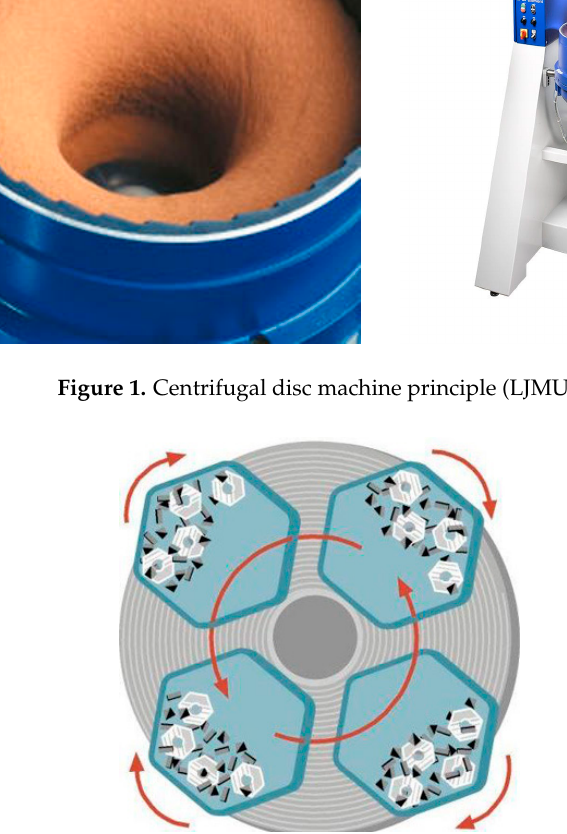
Figure 1. Centrifugal disc machine principle (LJMU).